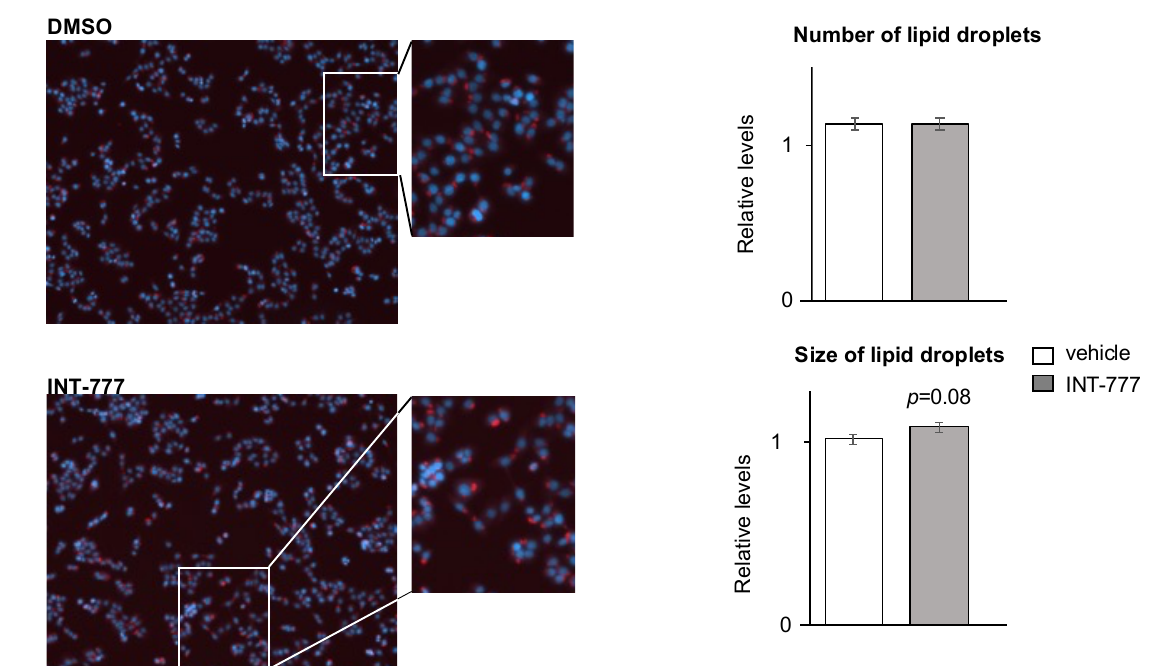
Figure 5. TGR5 modulated lipid metabolism in a mouse Leydig cell line. Representative images mLTC1 cells 3 h after treatment with vehicle (DMSO) or INT-777 and stained with Nile-Red-O. Quantifications of the number and size of lipid droplets in mLTC1 cells 3 h after treatment with vehicle (DMSO) or INT-777 and stained with Nile-Red-O. In all panels, n = 9 to 12. Data are expressed as the means ± SEM.